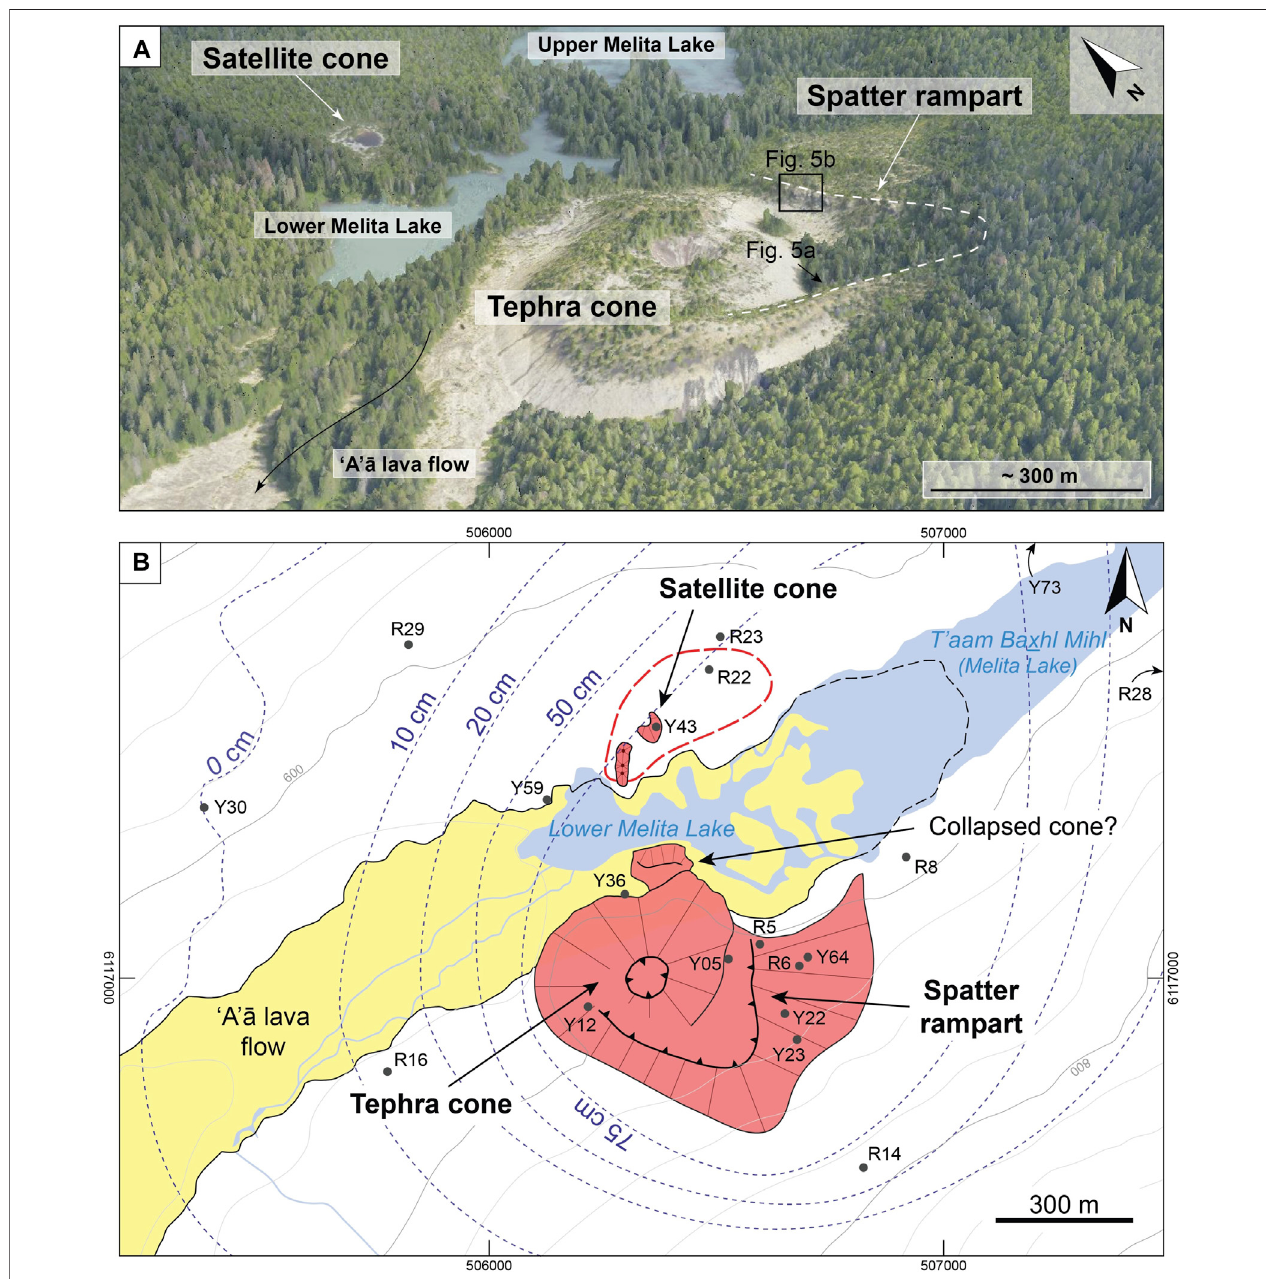
FIGURE 4 | (A) Oblique 3D view of Tseax and surrounding area generated by digital photogrammetry. Modi fi ed after Le Moigne et al. (2020). (B) Volcanological map of Tseax. Dashed lines are isopach contours. Red dashed line is the extent of tephra deposit from the Satellite cone. Labelled black dots are location of tephra samples collected for grain size and componentry analyses. Samples Y73 and R28 are located further